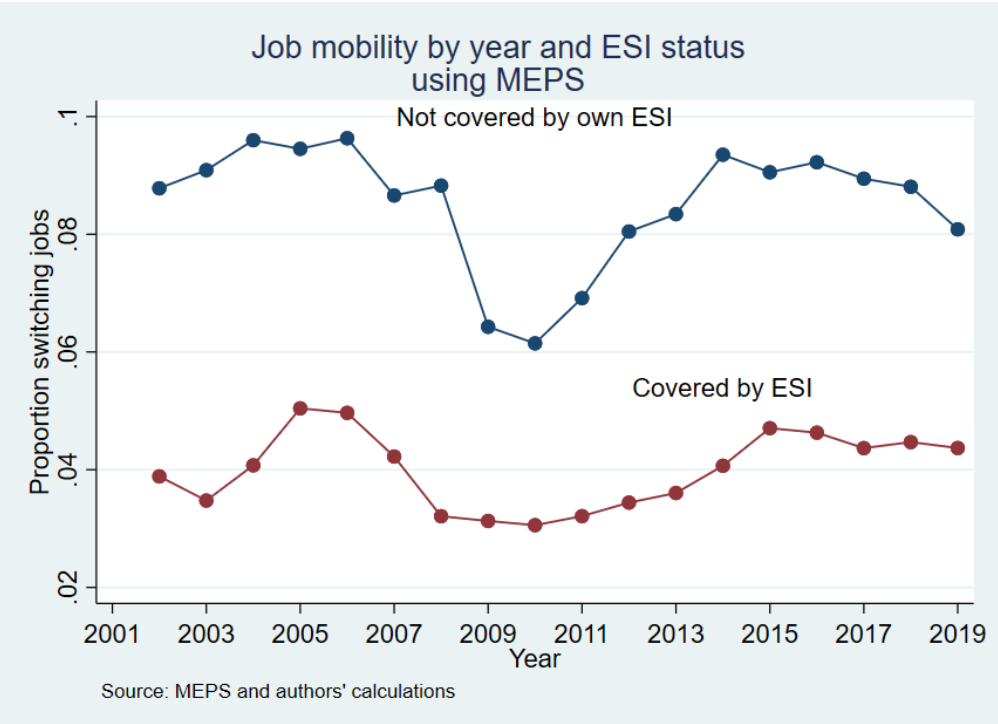
Figure 1. Trends in Job Mobility across ESI Status in the MEPS.